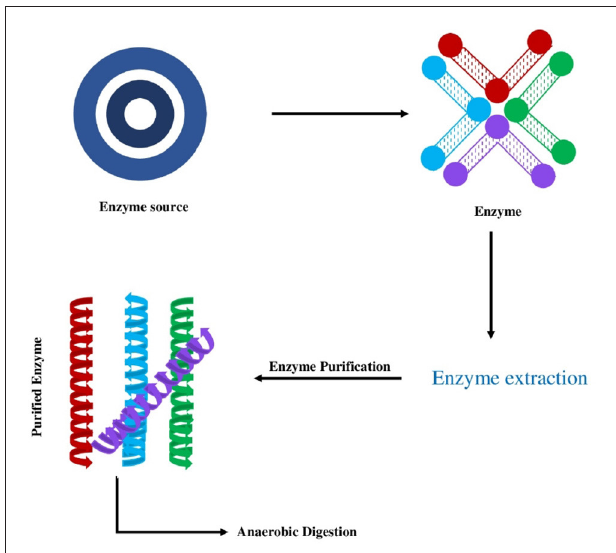
FIGURE 4 | Extraction of enzymes for application in anaerobic